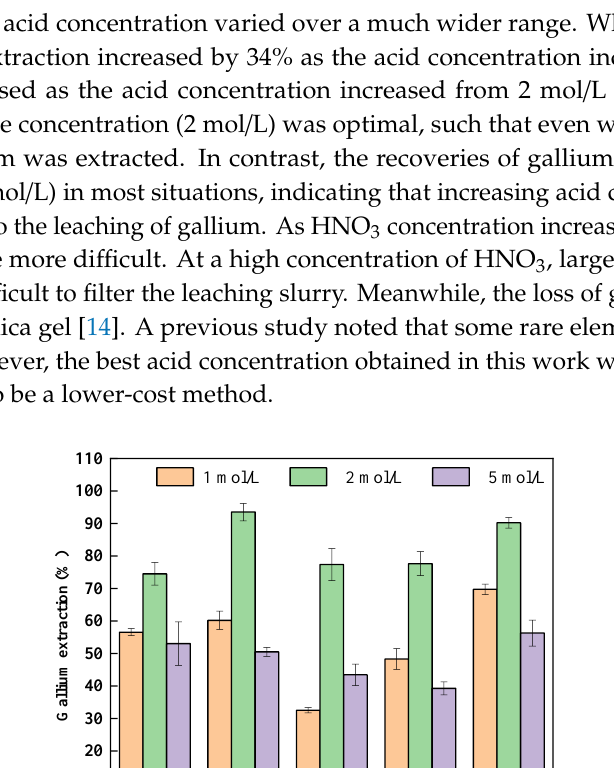
Figure 8. Influence of acid leaching temperature on gallium extraction (the NaF-CFA mass ratio of 0.75:1, roasting temperature of 800 ◦ C, roasting time of 10 min, leaching time of 2 h, and HNO 3 concentration of 2 mol / L).